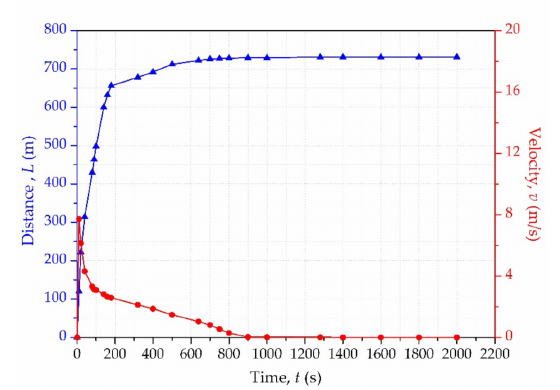
Figure 7. Distance and velocity of the front flow during the evolution